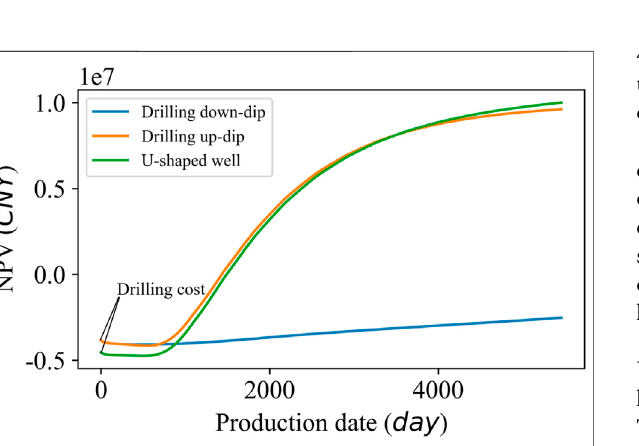
FIGURE 8 | Production comparison between different drilling directions: (A) gas production, (B) water production, (C) cumulative gas production, and (D) cumulative water production.